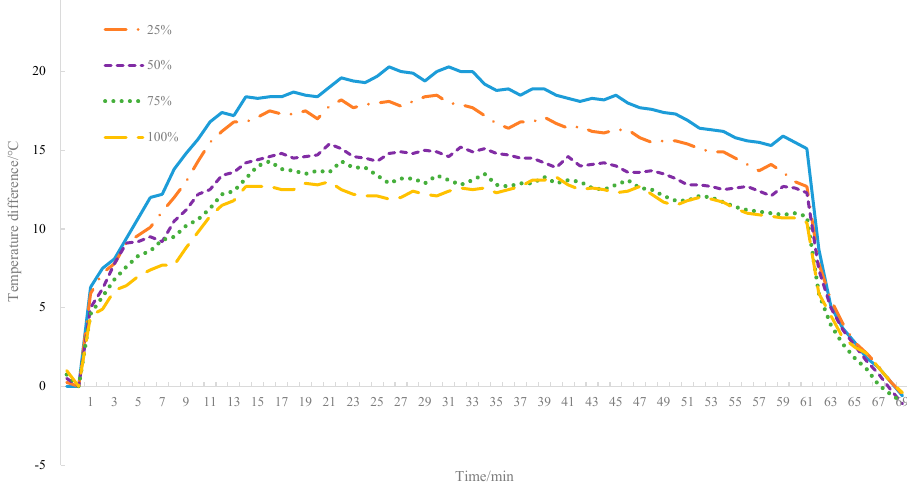
Figure 8 Residual curves Figure 8. Residual curves.